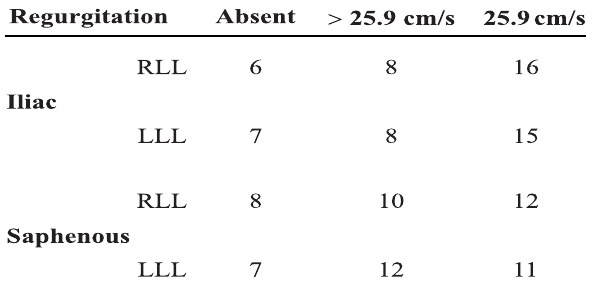
RLL and LLL: Right and Left Lower Limbs